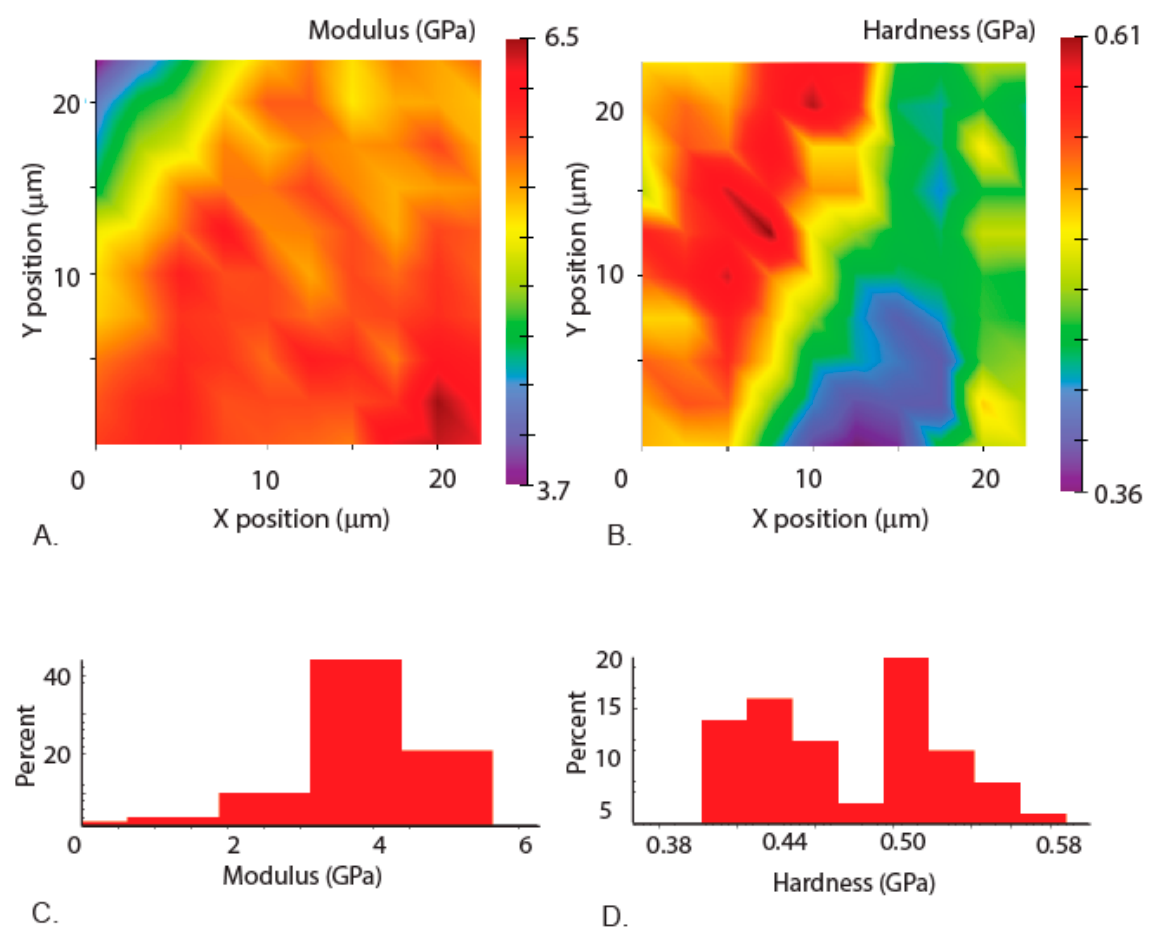
Figure 8. Nanoindentation measurements from the tip region (as shown in Figure 6C). ( A ) Elastic modulus mapping across the layers. ( B ) Hardness mapping across the layers. ( C ) Corresponding elastic modulus values sorted into bins to show the variation and percentage. ( D ) Corresponding hardness values sorted into bins to show the variation and percentages.